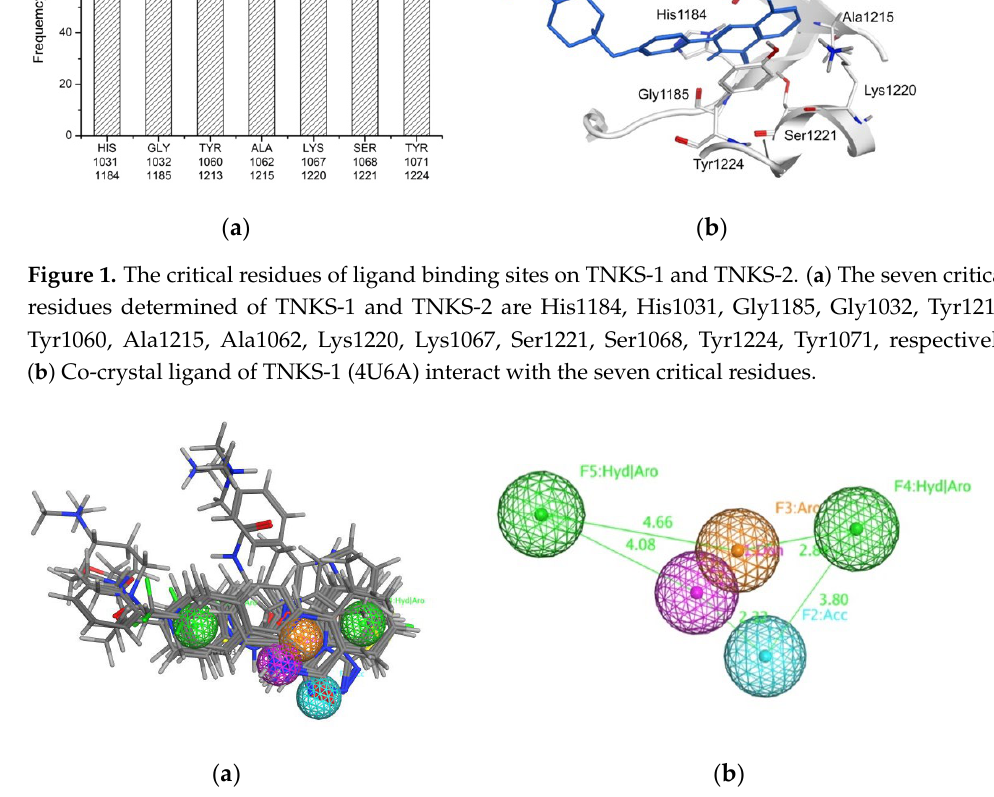
Figure 2. The defined pharmacophore model of TNKS protein. ( a ) 10 crystal structures and co-crystal ligands were superposed. ( b ) The purple is F1 donor, the cyan is F2 acceptor, the orange is F3 aromatic, and the two greens are F4 and F5 aromatic or hydrophobic. The F2 and F3 are defined as essential ligand features. Table 1. List of pharmacophore